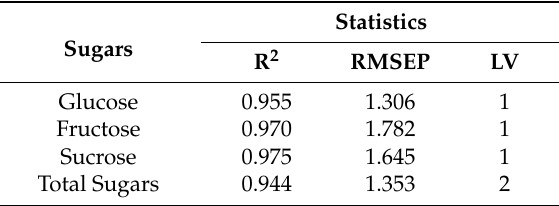
Table 2. Statistical values of Partial Least Square (PLS) discriminant analysis for the quantification of the studied fermentable sugars for EIS phase data from 6.6 × 10 5 Hz–7.0 × 10 5 Hz. (R 2 : coefficient of determination; RMSEP: Root Mean Square Error of Prediction; LV: Latent Variables).